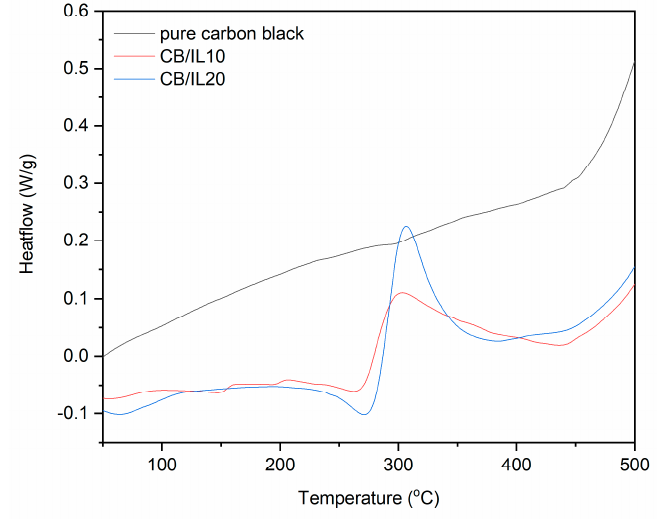
Figure 9. DSC curves for pure and DmiBr-modifed CB (exo^).